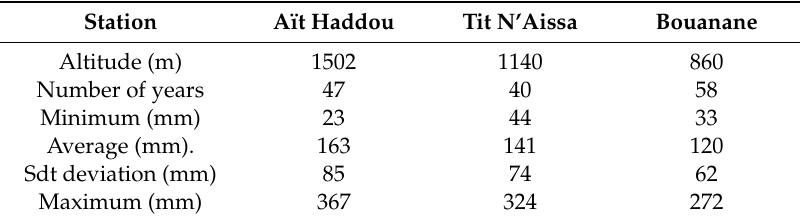
Table 1. Statistics of annual rainfall at the three meteorological stations in the Eastern Upper Guir area. Location of the stations is given in Figure 5.